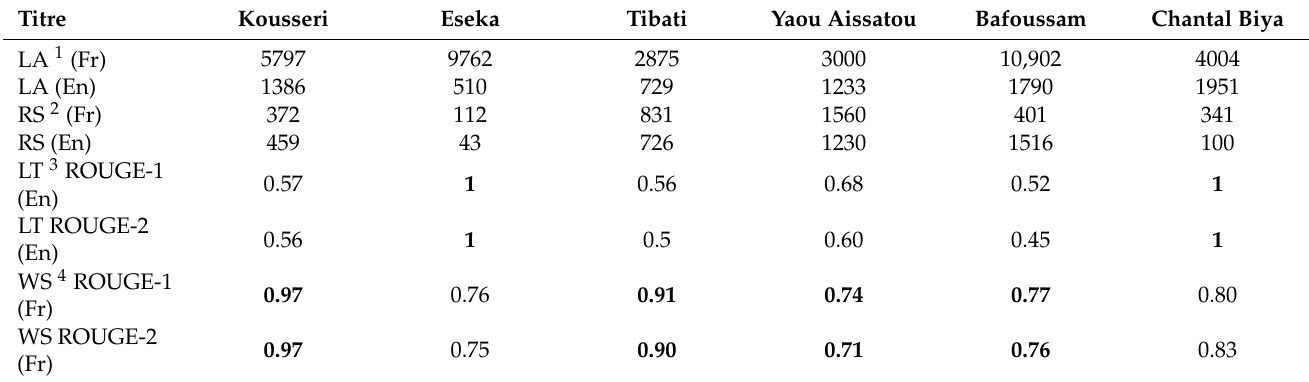
Table 1. Comparison of Wikipedia article with length over than 2000